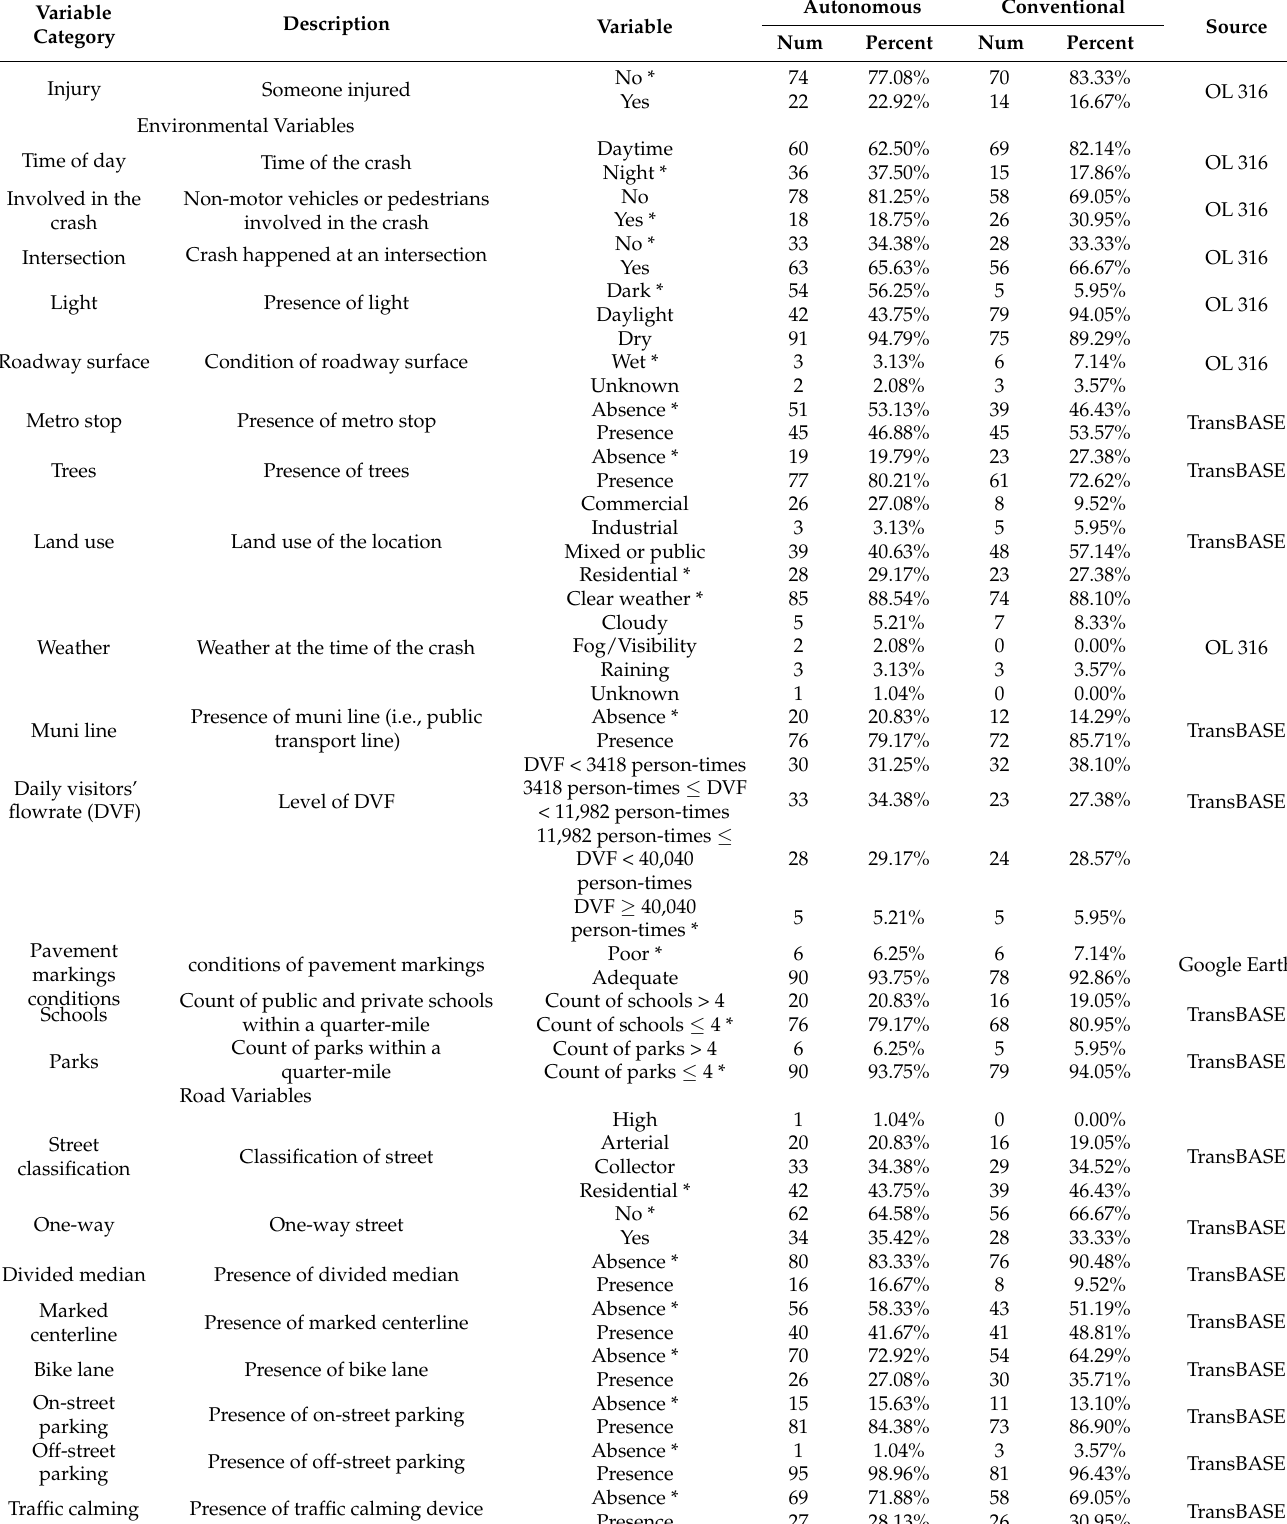
Table 2. Descriptions, distribution, and sources of explanatory